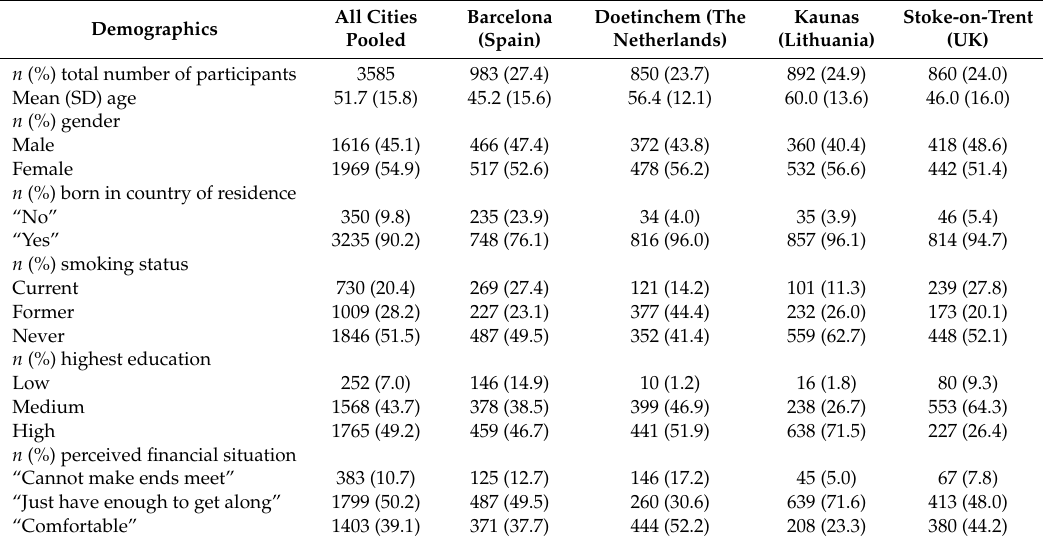
Table 1. Demographics of the study population: pooled and city-specific analyses.